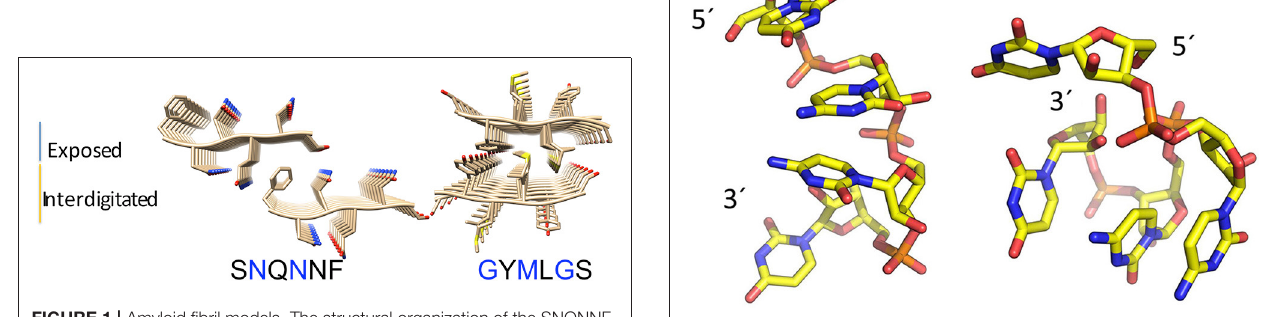
FIGURE 2 | Representative structures of the two main conformational clusters of UCCU RNA model obtained by MD simulations. The 5 ′ and 3 ′ ends are